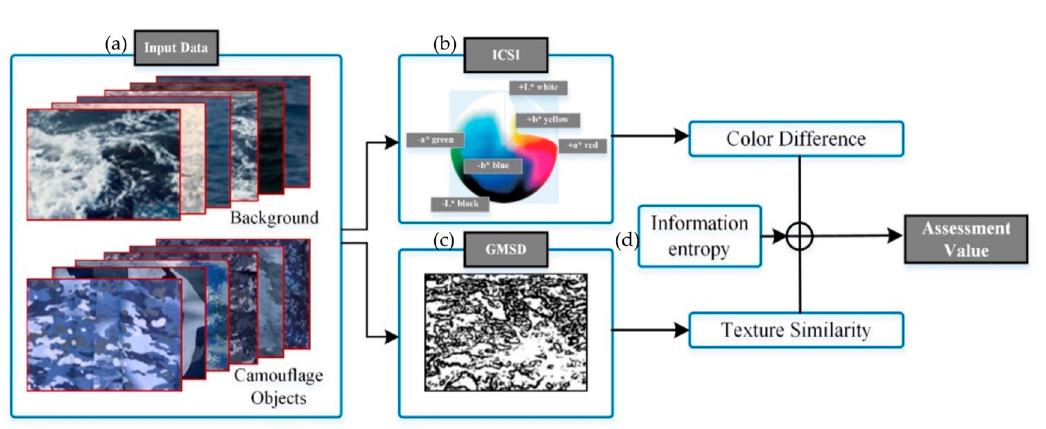
Figure 1. Schematic diagram of the proposed model for assessing camouflage effectiveness: ( a ) Input data of the camouflage object image and the objective-overlapping region of the background image to the model; ( b ) the algorithm of image color similarity index (ICSI); ( c ) The algorithm of gradient magnitude similarity deviation (GMSD); ( d ) Determine the weights of each metric using the information entropy method.